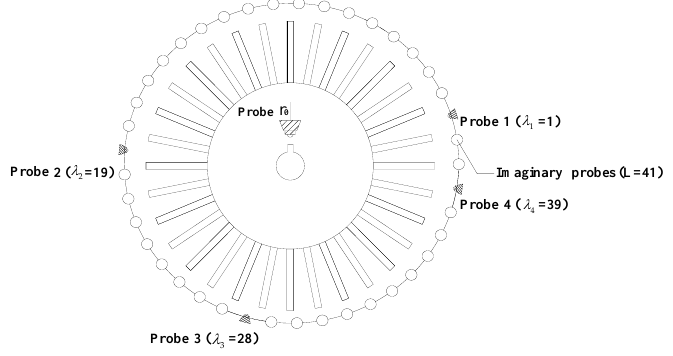
Figure 14. Placement of optical probes.